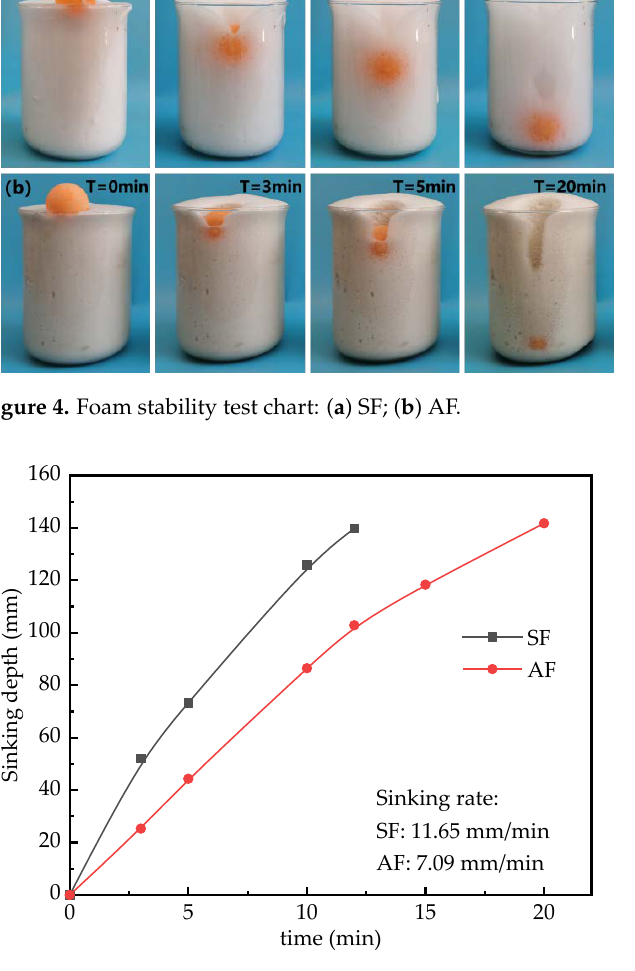
Figure 5. The settlement curve.